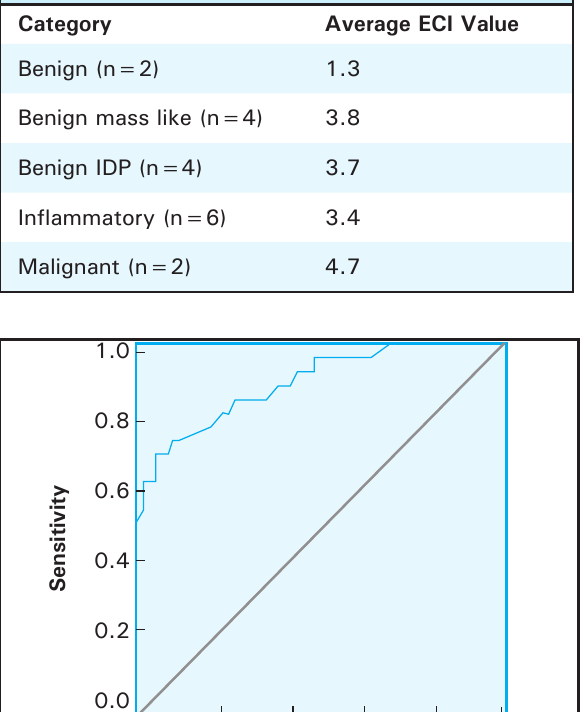
Table 1. ECI value of indeterminate lesions.